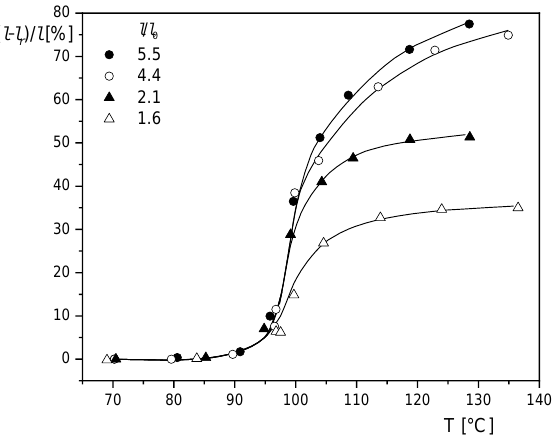
Figure 7. Shrinkage ratio ( l − l r ) / l as function of the annealing temperature T of polystyrene films previously stretched to di ff erent draw ratios l / l 0 at 130 ◦ C and subsequently precipitated. The annealing time was 15 min [17].